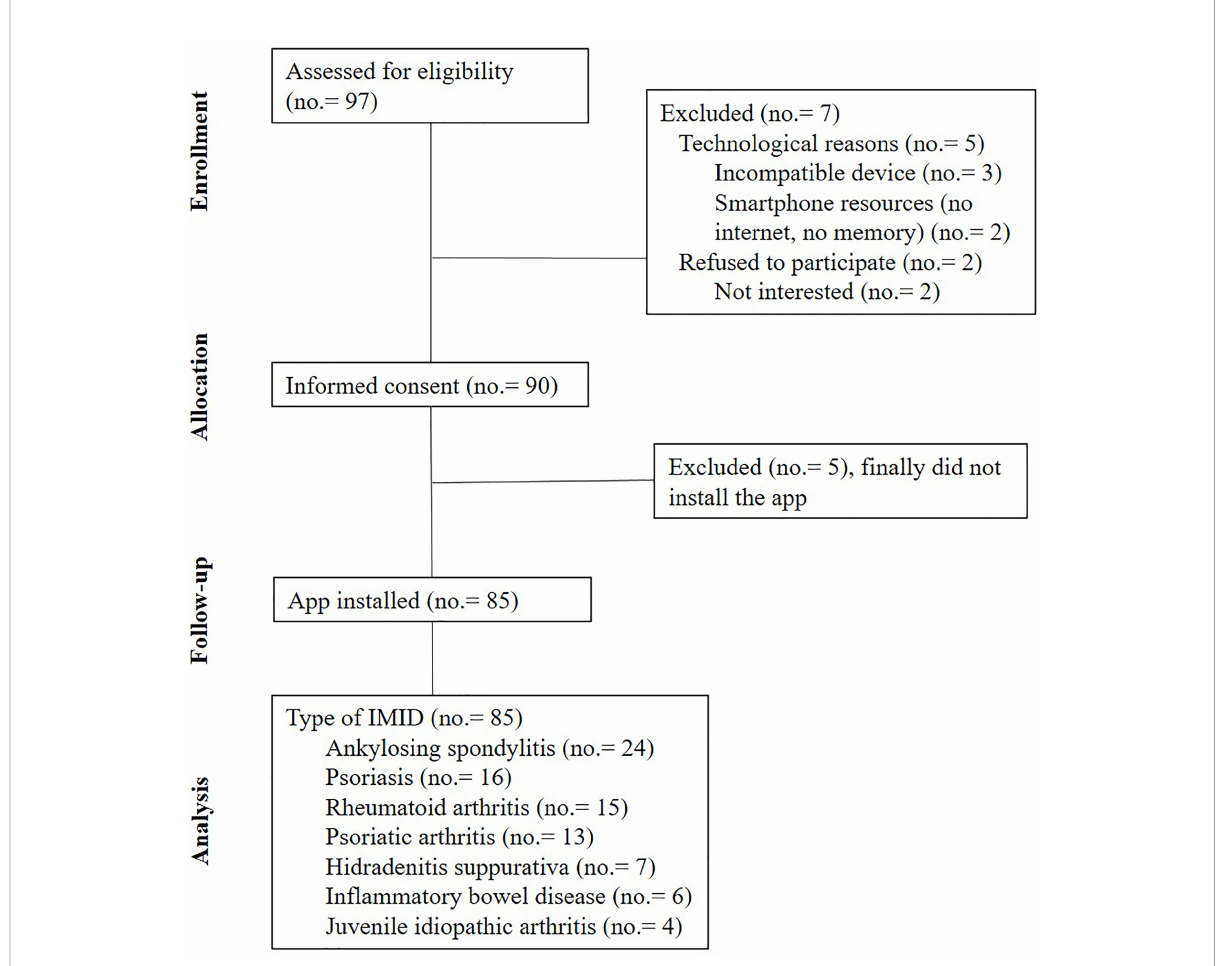
FIGURE 2 Patient inclusion